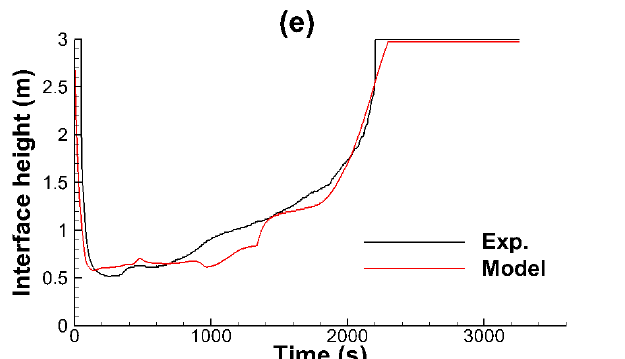
Figure 9. Test 1: ( a ) individual and total HRRs, ( b ) average gas temperature, ( c ) average wall temperatures, ( d ) volume fractions of O 2 and CO 2 in the exhausted gases, and ( e ) smoke layer interface height.